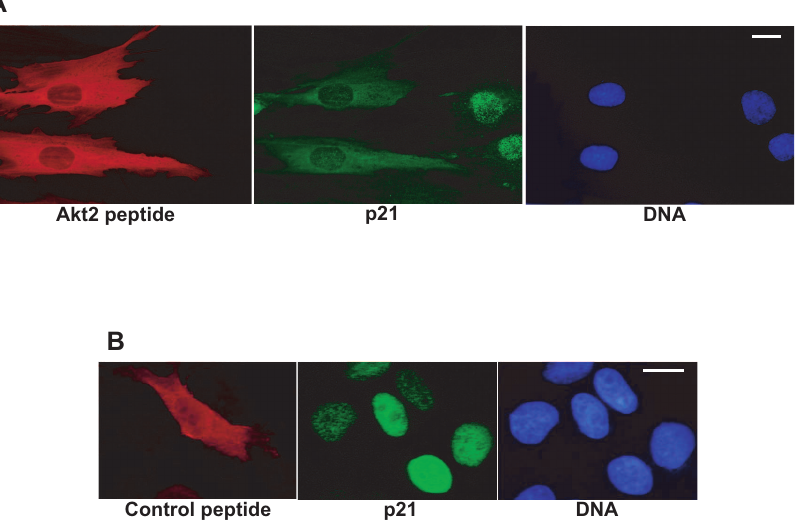
Figure 4. Effect of Akt2 peptide microinjection on endogenous p21cip1 protein stabilization. The Akt2 synthetic peptide (410–437) or a control peptide (spanning amino acids 425–452 of cdc25C) were microinjected into quiescent human myoblasts and cells were fixed 40 minutes after to avoid peptide degradation before immunofluorescence to detect endogenous p21cip1 and check for its localization/stabilization. Bars in both panels =10 m M.